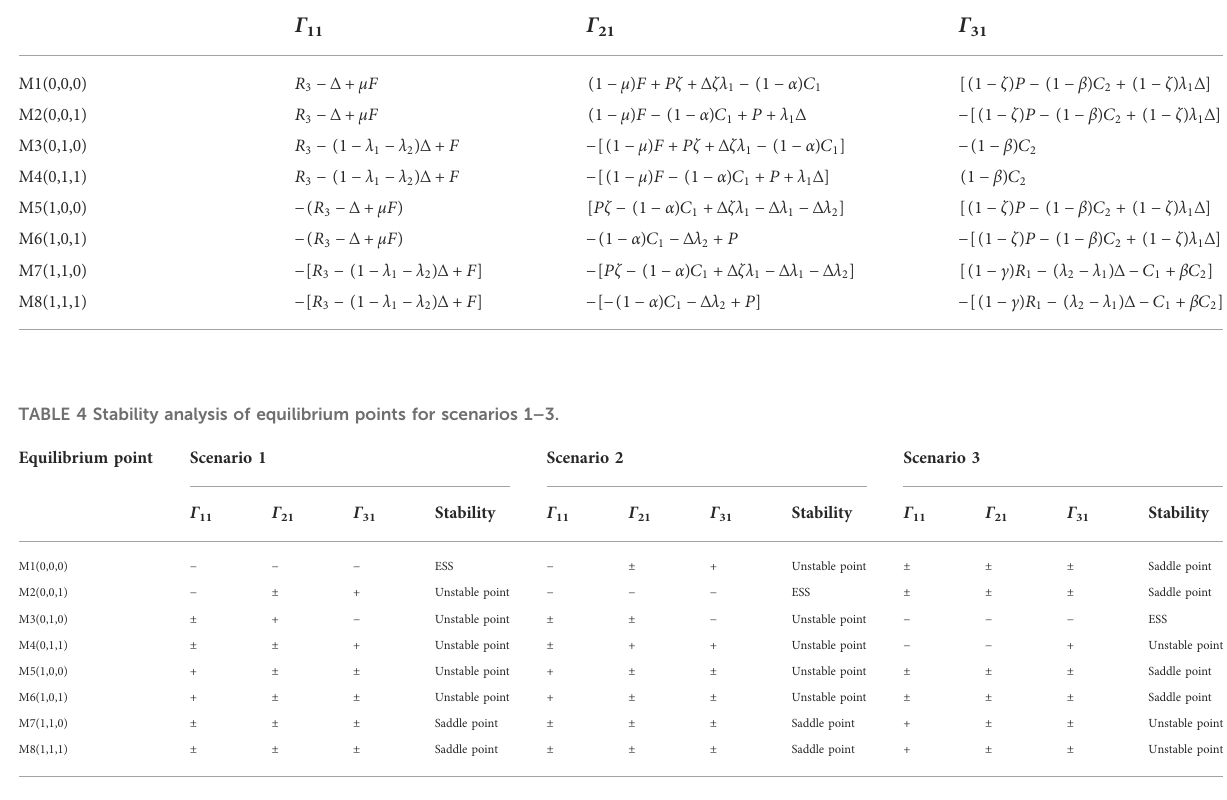
Table 5, the system has the unique equilibrium point of (1,0,1). The stabilization strategies are “ cooperation, ” “ passive governance, ” and “ strict supervision ” for the farmers, local governments, and central government, respectively. Scenario